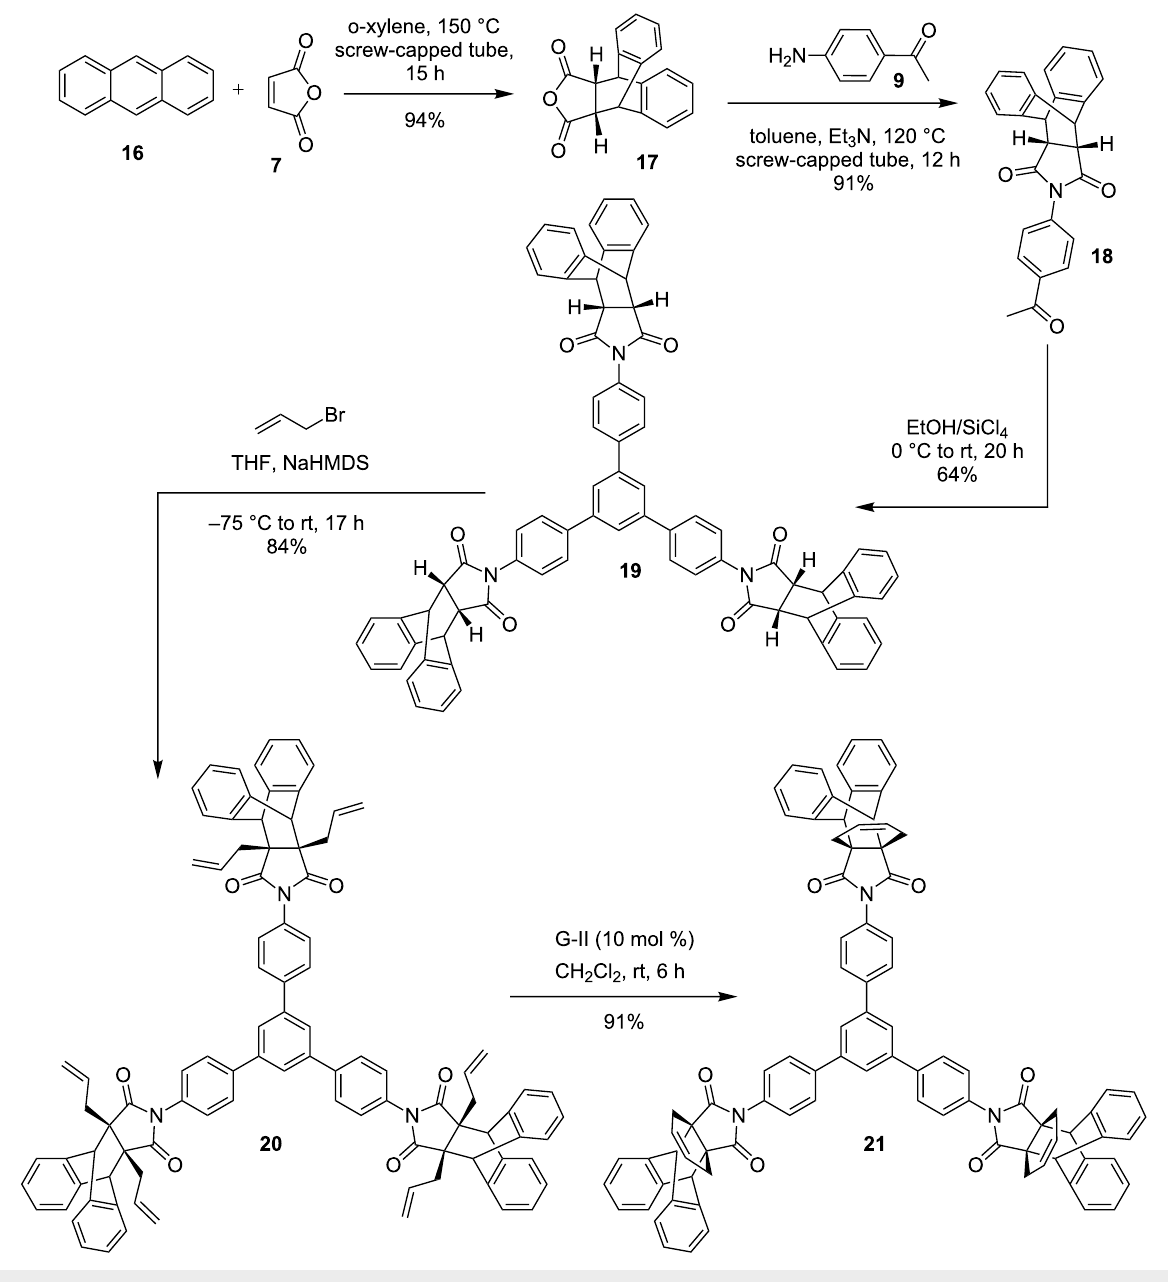
Melting points were recorded on a Veego or Büchi melting point apparatus and are uncorrected. NMR Spectra were gener- ally recorded on Bruker (Avance 400 or Avance III 500) spec- trometers operated at 400 or 500 MHz for 1 H and 100 or 125.7 MHz for 13 C nuclei. NMR Samples were generally made in chloroform- d solvent, and chemical shifts ( δ values) are re- ported in parts per million (ppm). Coupling constants ( J values) were reported in hertz (Hz). HRMS measurements were carried out using a Bruker (Maxis Impact) spectrometer. IR